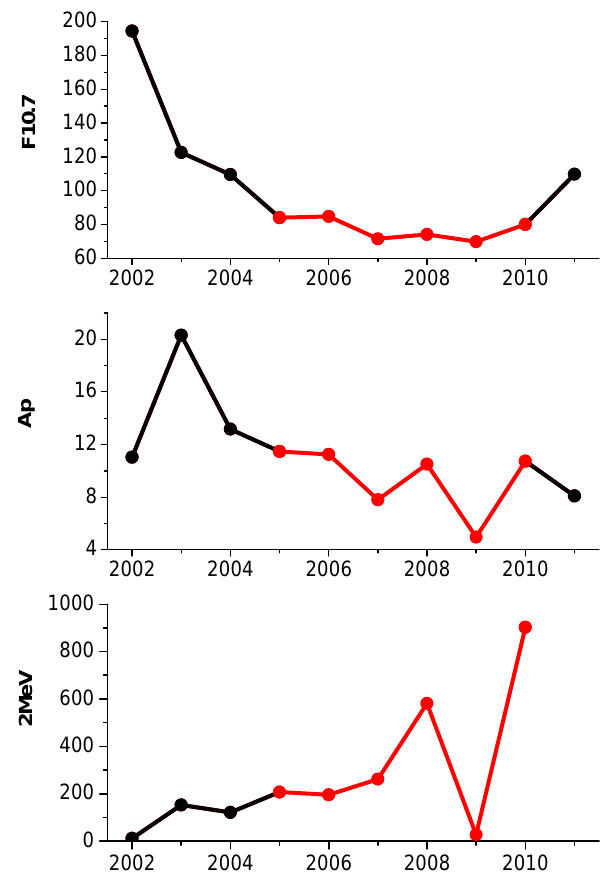
Figure 4. Time series from 2002 to 2011 of the 26-day aver- ages centred around 1 April of the F10.7cm solar radio flux (10 − 22 Wm − 2 Hz − 1 , top), Ap index (middle), and ≥ 2MeV elec- tron flux (electronscm − 2 day − 1 sr − 1 , bottom). The period of low solar activity from 2005 to 2010 is marked in red. Note the different